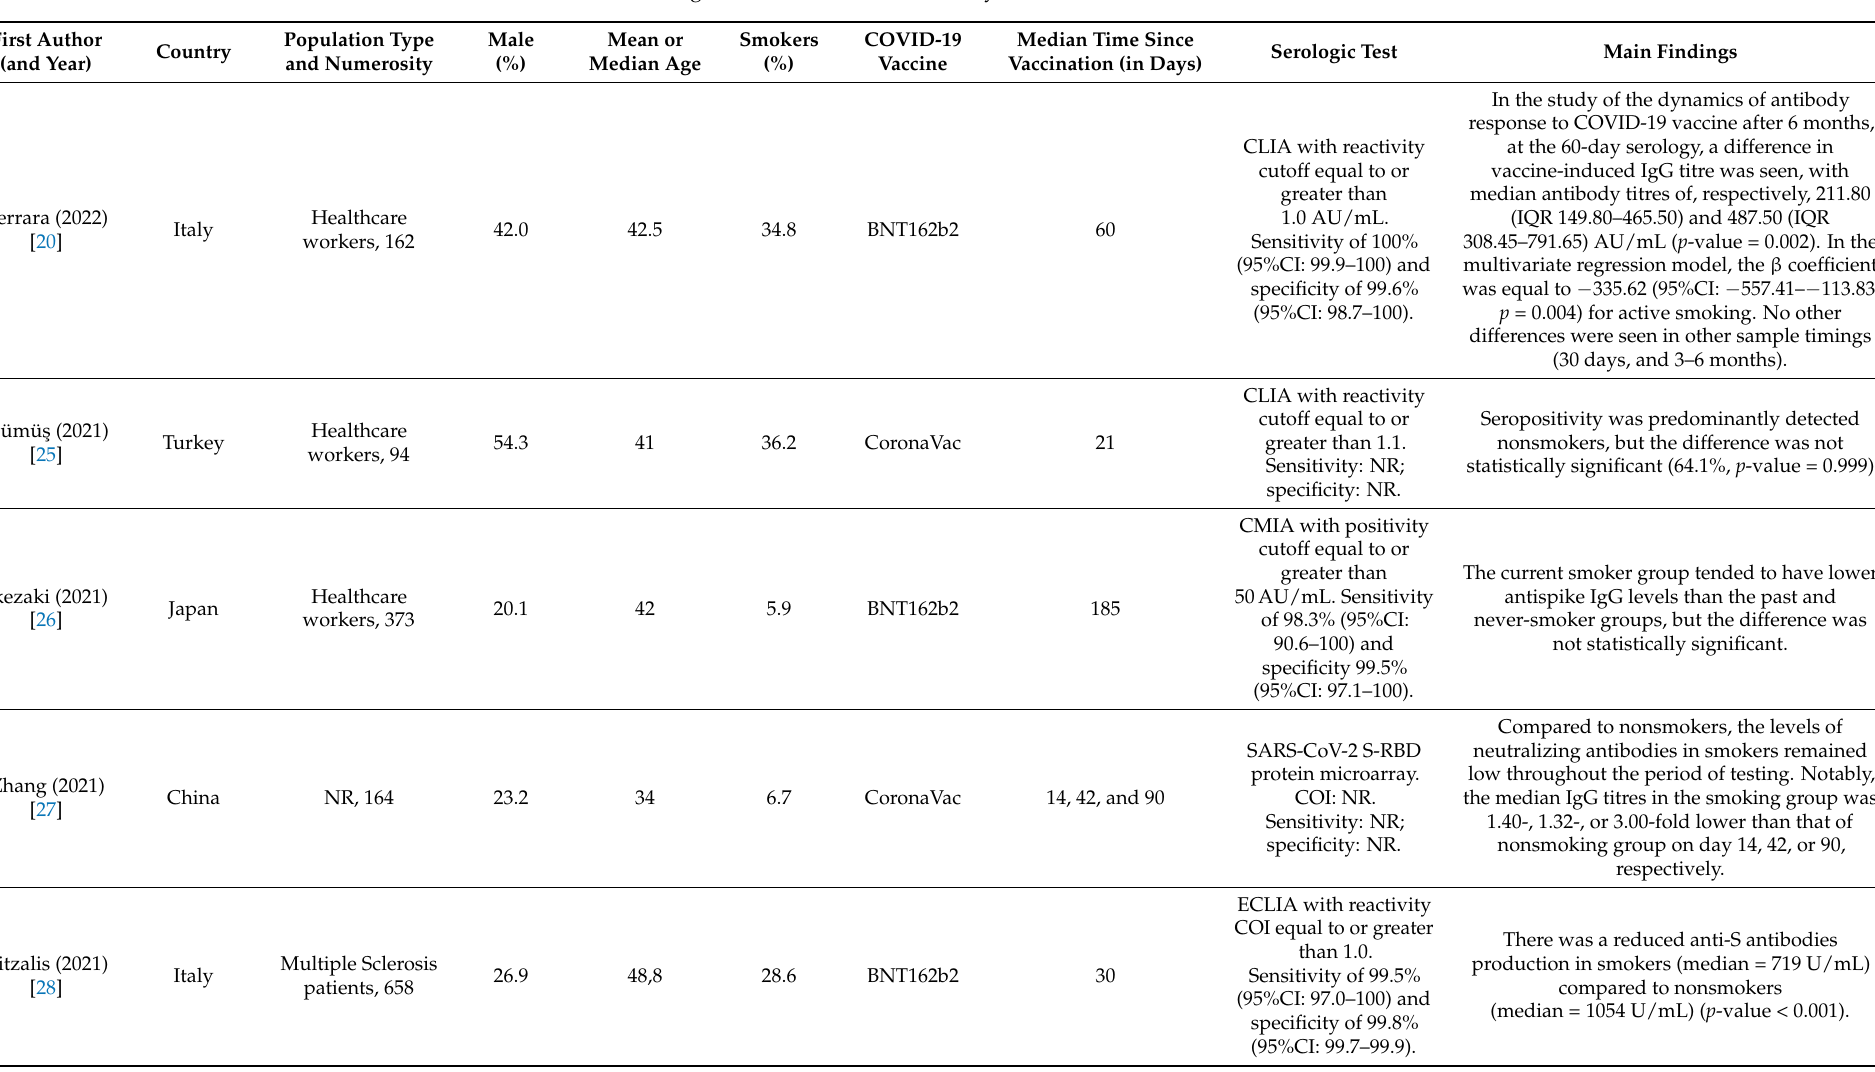
Table 1. Characteristics and main findings of studies included in the systematic